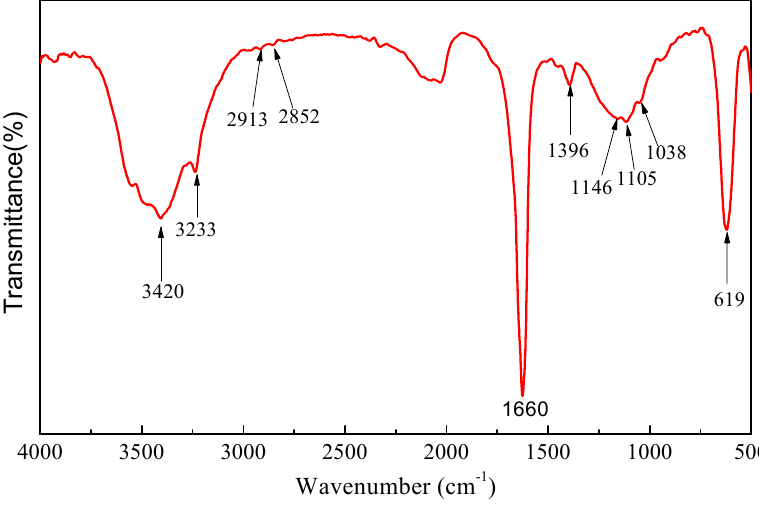
Figure 1. The FTIR spectrum of DiPHAM.